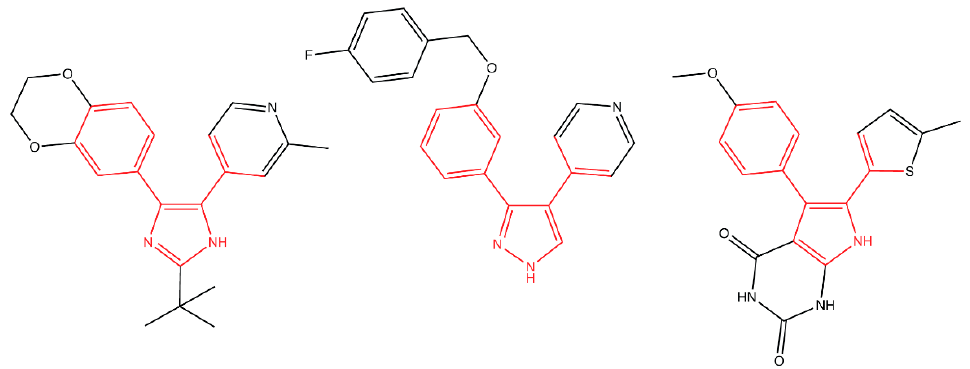
Figure 4. Inhibitors of the LolCDE complex show structural similarities. Nayar’s compound 2 (left), McLeod’s compound 2 (center), and Nickerson’s G0507 (right) all inhibit the LolCDE complex. Structural similarity between the three compounds is highlighted in red.